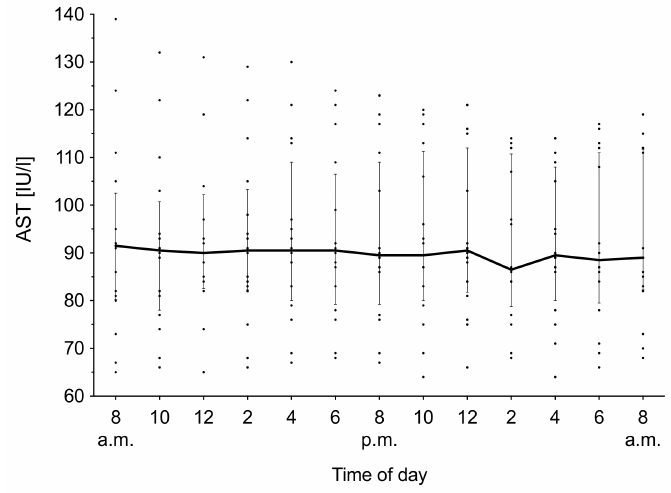
Figure 5. Aspartate aminotransferase (AST) concentration in serum over 24 h. Data expressed as median over all groups ( n = 16) with the interquartile rage as error bars. Individual measurements are depicted as aligned